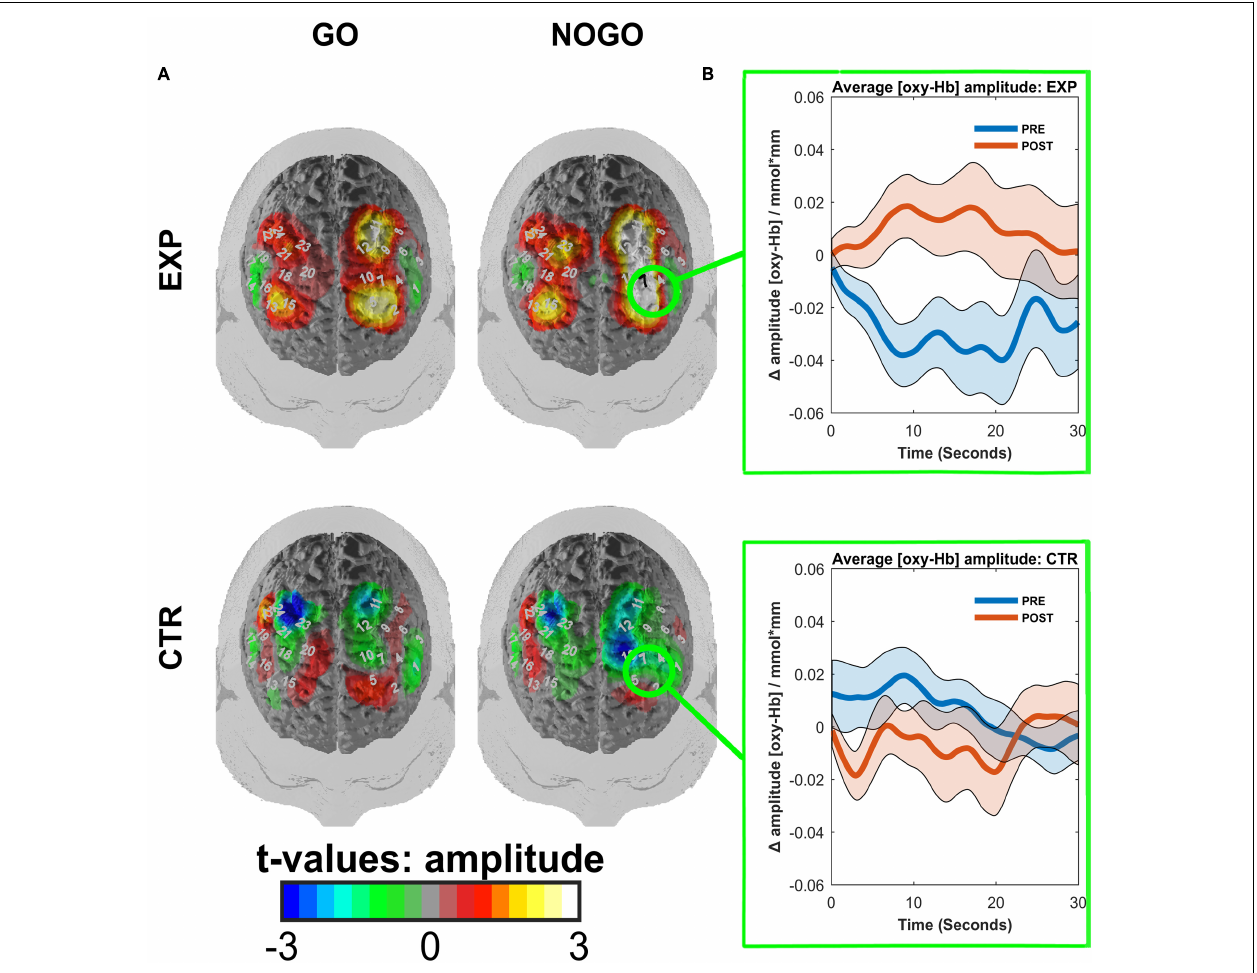
FIGURE 5 | (A) Contrasted t-maps of the average amplitudes of O 2 Hb for different blocks of the go/no-go task. Contrasts represent post-test values minus pre-test values. CTR represents the EMG control group, while EXP represents the experimental fNIRS group. T -values were obtained by t -tests corrected for multiple comparisons with the Armitage–Parmar correction. Positive channels indicate stronger activation in the post-relative to the pre-test. Significant channels are depicted in black. (B) ROI event-related averages. Circled regions from (A) indicate the left dlPFC ROI for which the event-related average of O 2 Hb ± standard error of the mean (SEM) is depicted for both pre-(blue) and post-(red)